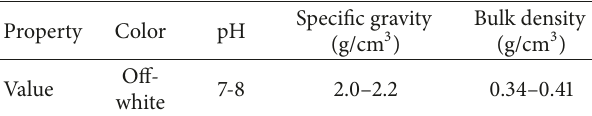
Table 2: Properties of diatomite.